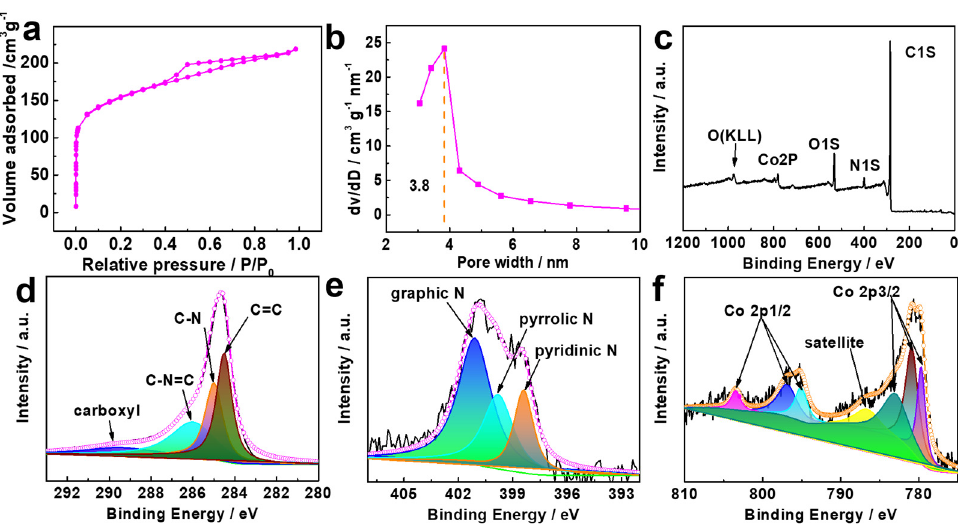
Figure 4. ( a ) Nitrogen sorption/desorption isotherm of the Co/N-C-900, ( b ) the corresponding pore width distribution curve, ( c ) XPS spectra survey of Co/N-C-900, ( d ) C1s XPS spectra, ( e ) N1s XPS spectra, ( f ) Co2p XPS spectra.